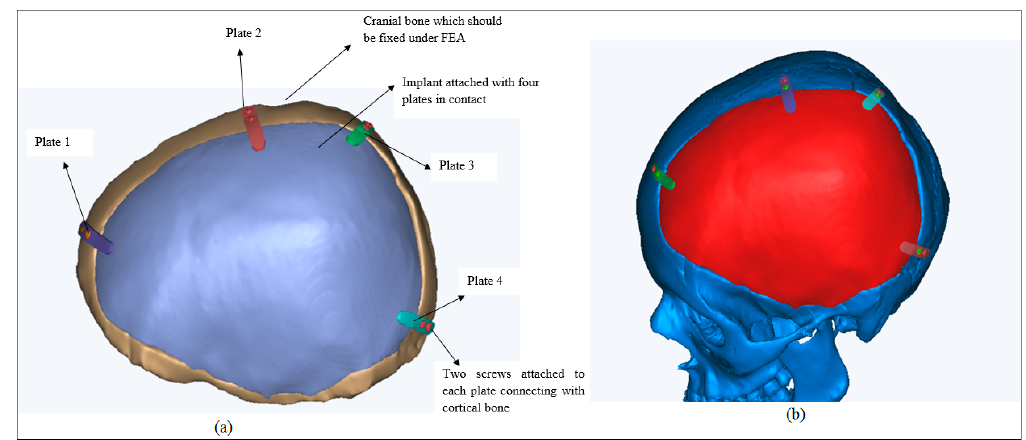
Figure 6. ( a ) Cranial implant with fixation plates; ( b ) Implant fixed on the prototype.